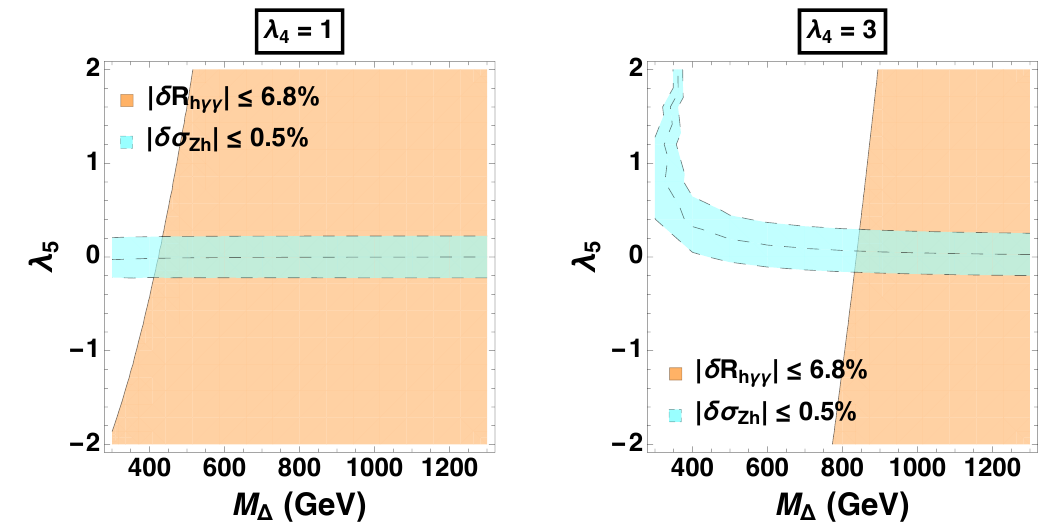
Figure 4. Contour comparison of | δσ Zh | ≤ 0 . 5% (cyan band outlined with dashed lines) and | δR hγγ | ≤ 6 . 8% (orange area outlined with solid line) in complex triplet model in plane ( M ∆ , λ 5 ) with λ = 1 (left) and λ = 3 4 4